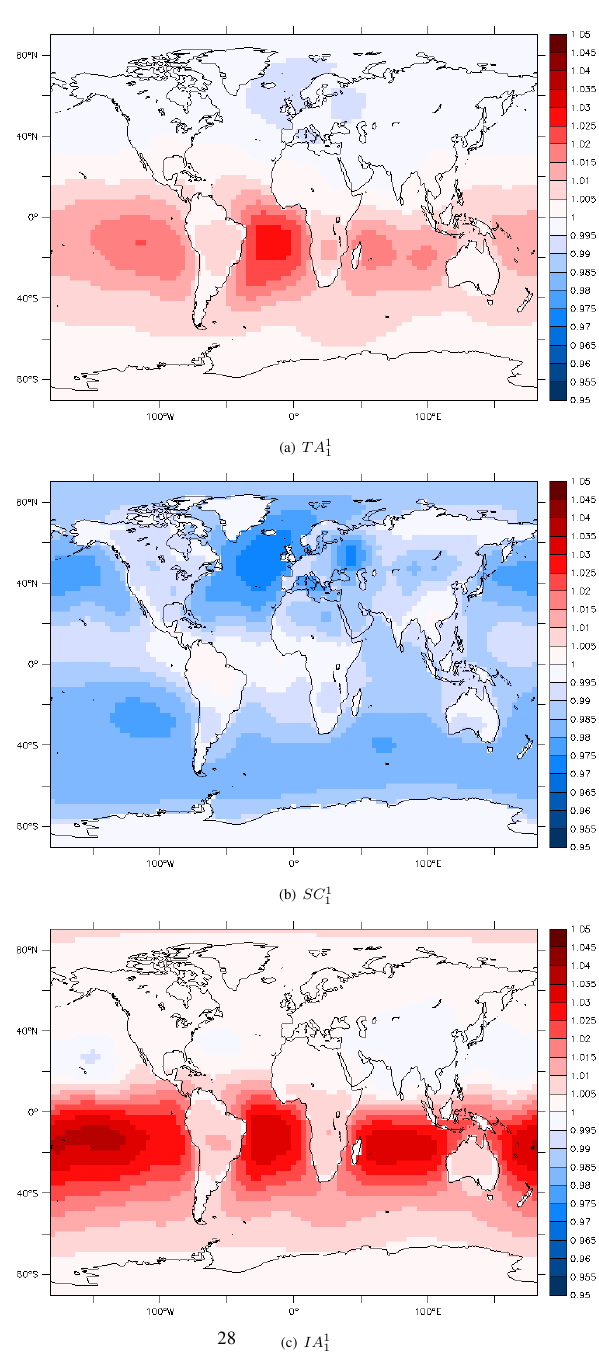
Fig. 5. Increments of the initial conditions of methane for the various inversions expressed as a fraction of the prior.